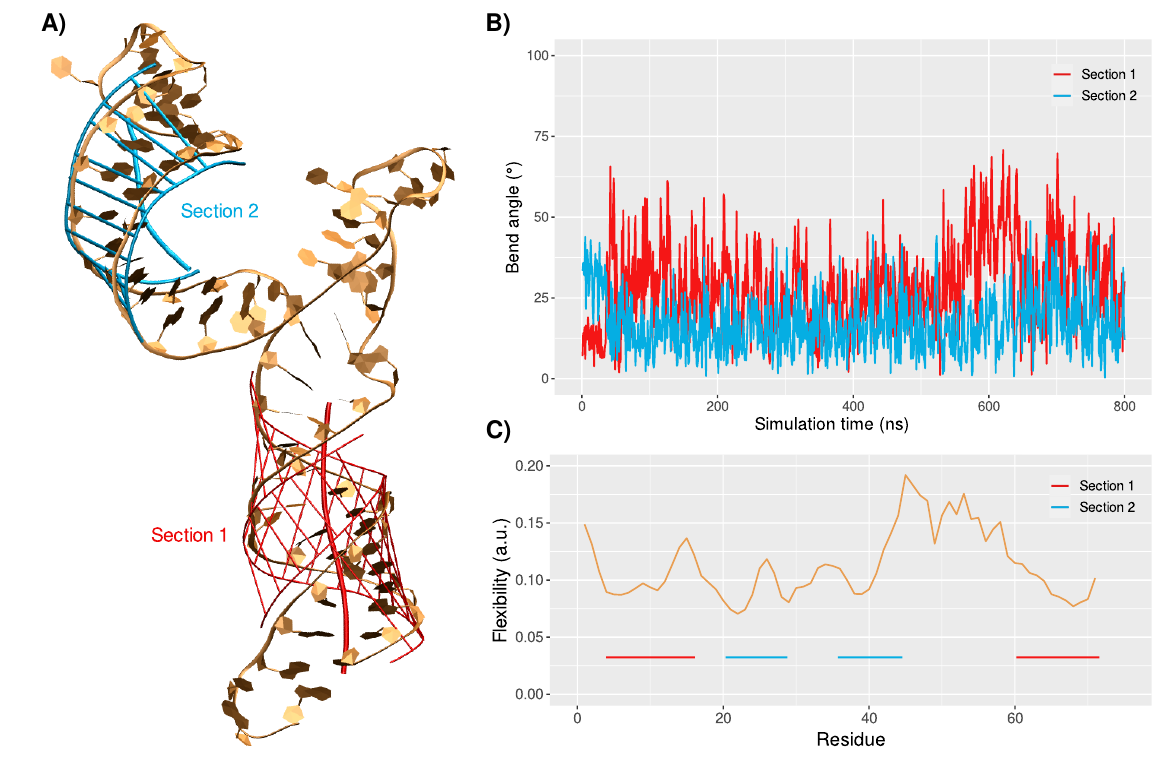
Figure 2. ( A ) Projection of the bend and network interaction in the stem sections 1 (red) and 2 (cyan) onto the 5 (cid:48) -UTR RNA major conformation. ( B ) Evolution of the local bend angles of the two stem sections. ( C ) Flexibility profile per residue of the 5 (cid:48) -UTR RNA. The stem regions are indicated by red (first section) and cyan (second section)